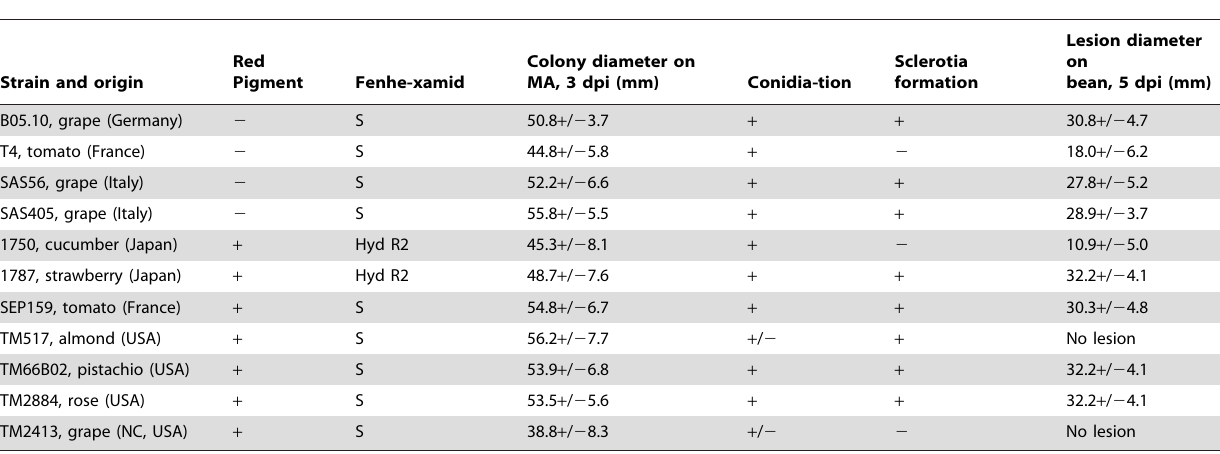
Table 1. Botrytis cinerea strains used in this